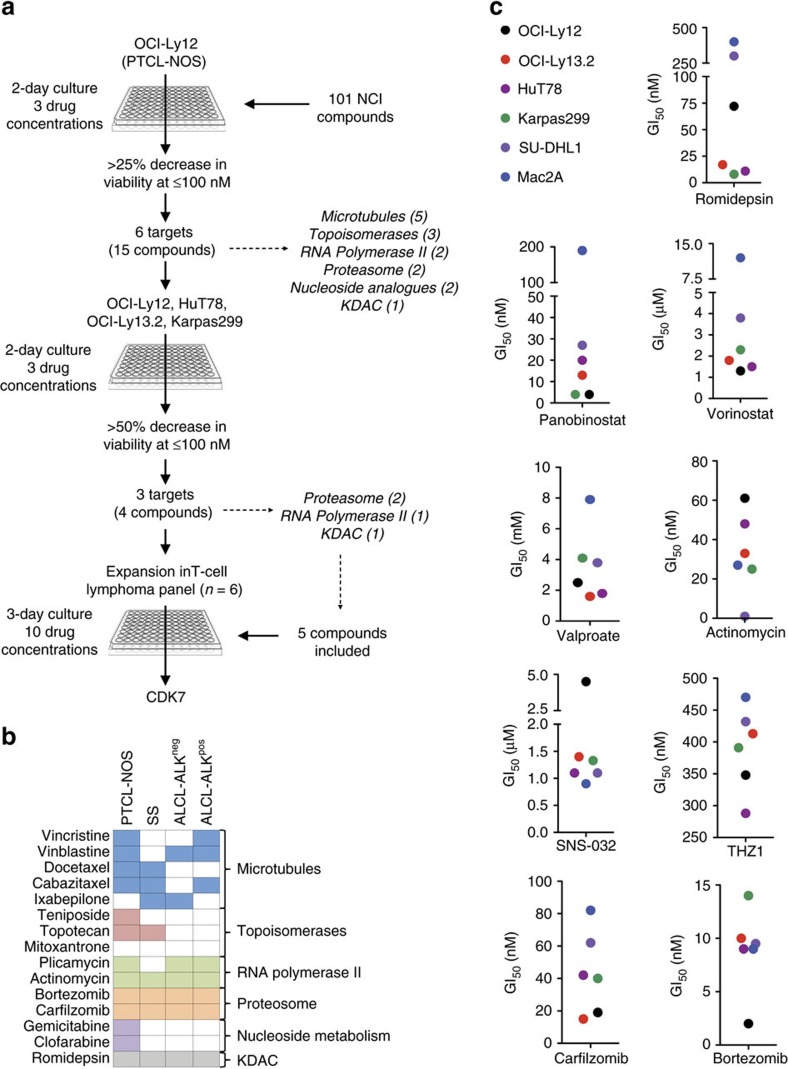
Screen for antineoplastic drugs and therapeutic targets in PTCL cell lines.(a) Screen setup and results. (b) Extended target validation in four PTCL cell lines (top). Drugs that showed >50% decrease in viability at <100 nM are shown as filled squares. (c) Growth inhibitory concentration 50% (GI50, Y axis) for nine compounds (shown on bottom) in an extended panel of six PTCL cell lines.